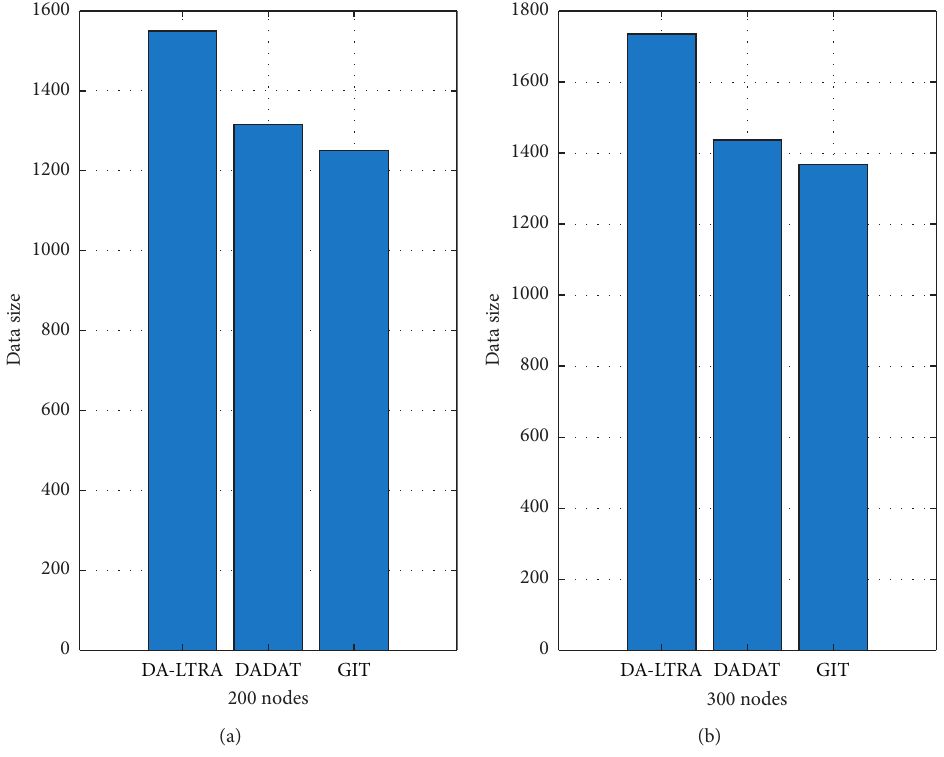
Figure 10: Number of packets of the network per round.